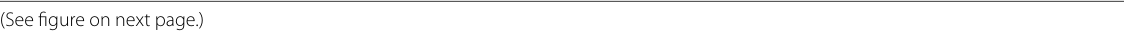
groups(See figure on next Fig. 2 Bacterial phyla relative abundance, alpha diversity measures, and beta diversity of fecal samples collected from cats fed the experimental diets. Shifts in fecal bacteria are demonstrated among the diet groups. A Relative abundances at the phylum level for each dietary group. B Alpha diversity differences between the diet groups. C Principal Coordinate Analysis (PCoA) of species-level gut microbiomes using Bray-Curtis distances. PERMANOVA was used to assess the association between diet and period with the gut microbiome composition. The Kruskal–Wallis test was used to assess association between diet and the top two axes (PCo1, PCo2) followed by Dunn’s post-hoc test to evaluate the difference between the dietary